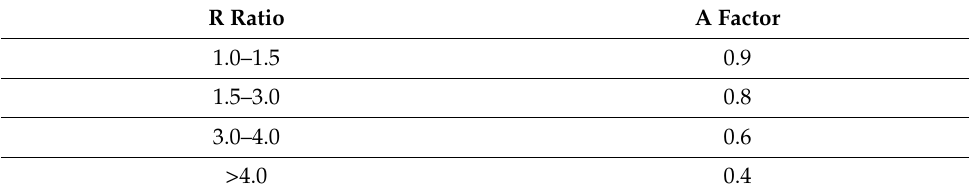
Table 4. Initial settings of A Factor and R